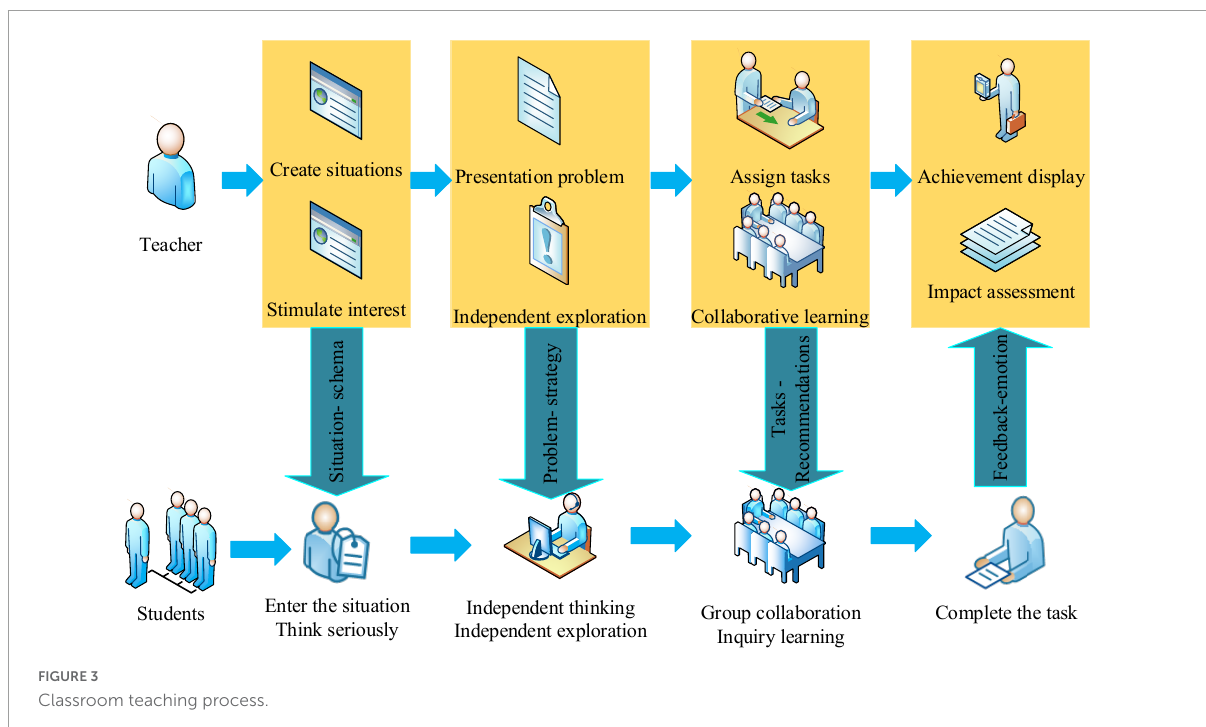
FIGURE3 Classroom teaching